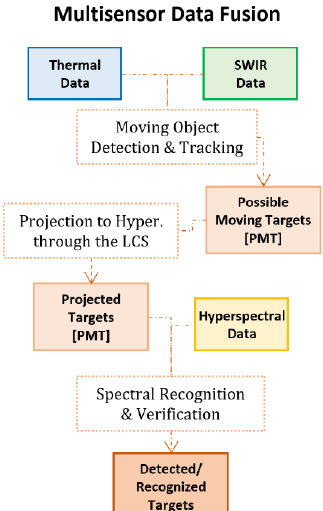
Figure 3: The processing pipeline for the multisensor data fusion